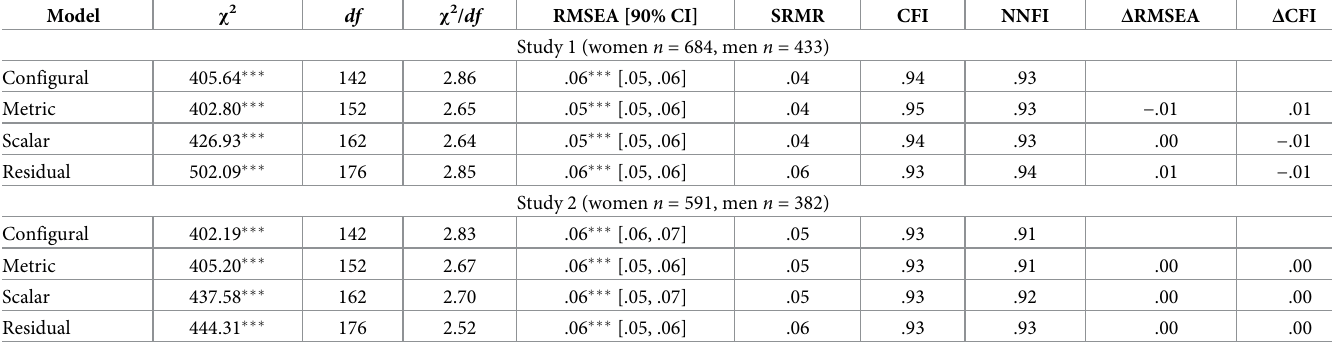
Table 5. Invariance of Parker et al.’s model of the eating disorder examination questionnaire [44] across